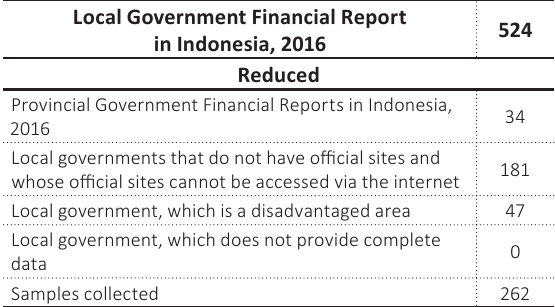
Table 2. Description of variables in the regression